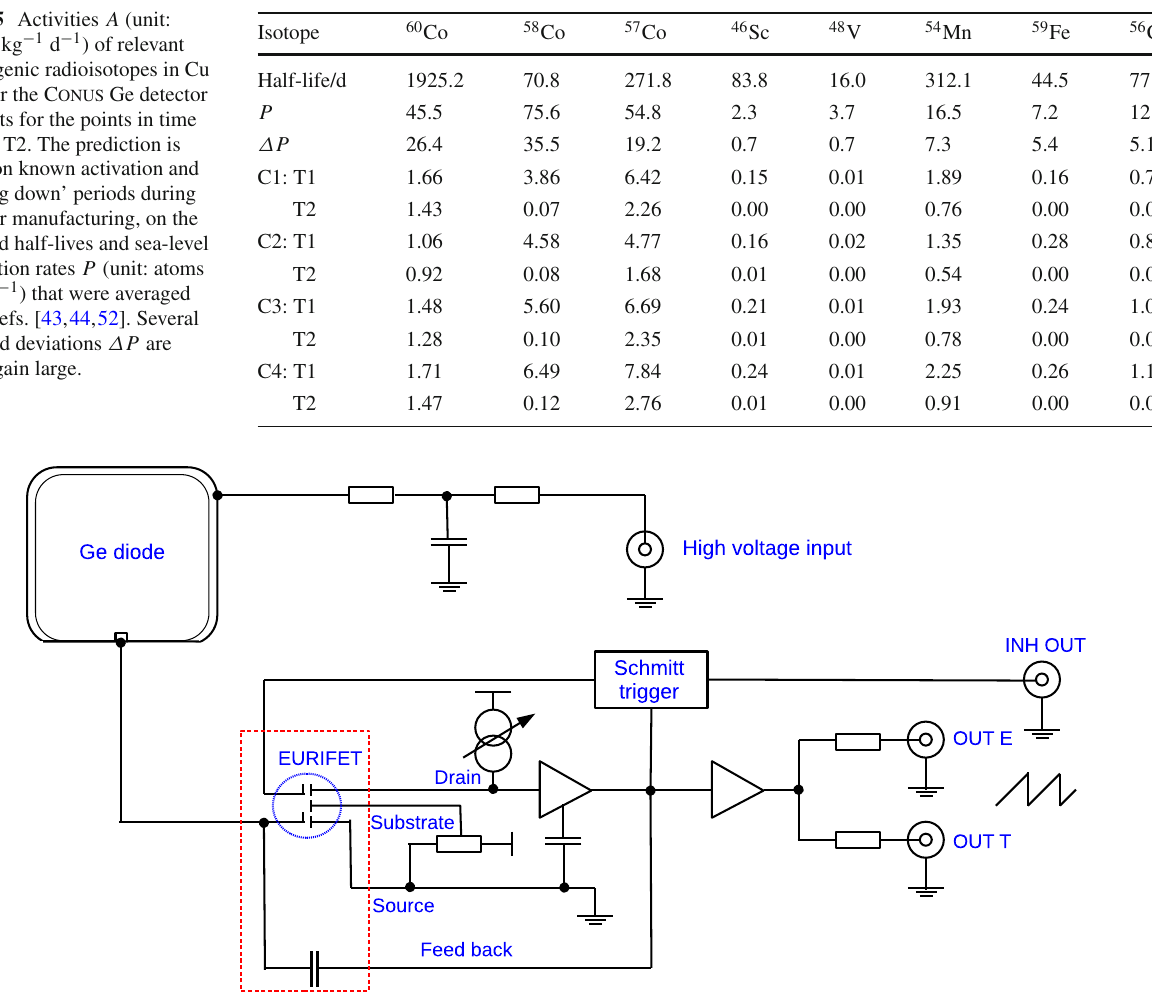
Fig. 7 Simplified representation of the signal detection and amplification electronics chain of the Conus detectors prior digitalization of the raw pulse traces. The cold front-end part of the electronics is outlined by the red dashed